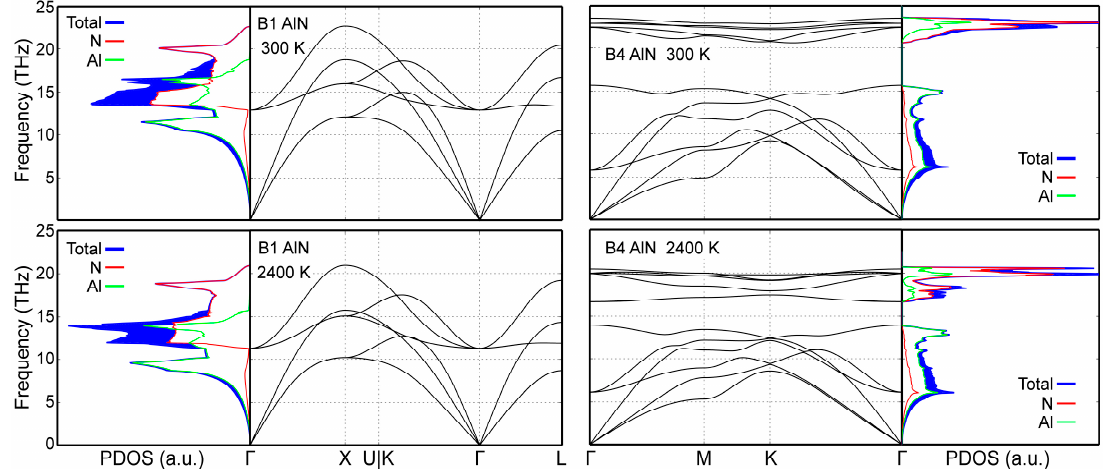
Figure 6. B1- and B4-AlN CMD phonon spectra and phonon densities of states (PDOS) calculated at 300 and 2400 K.